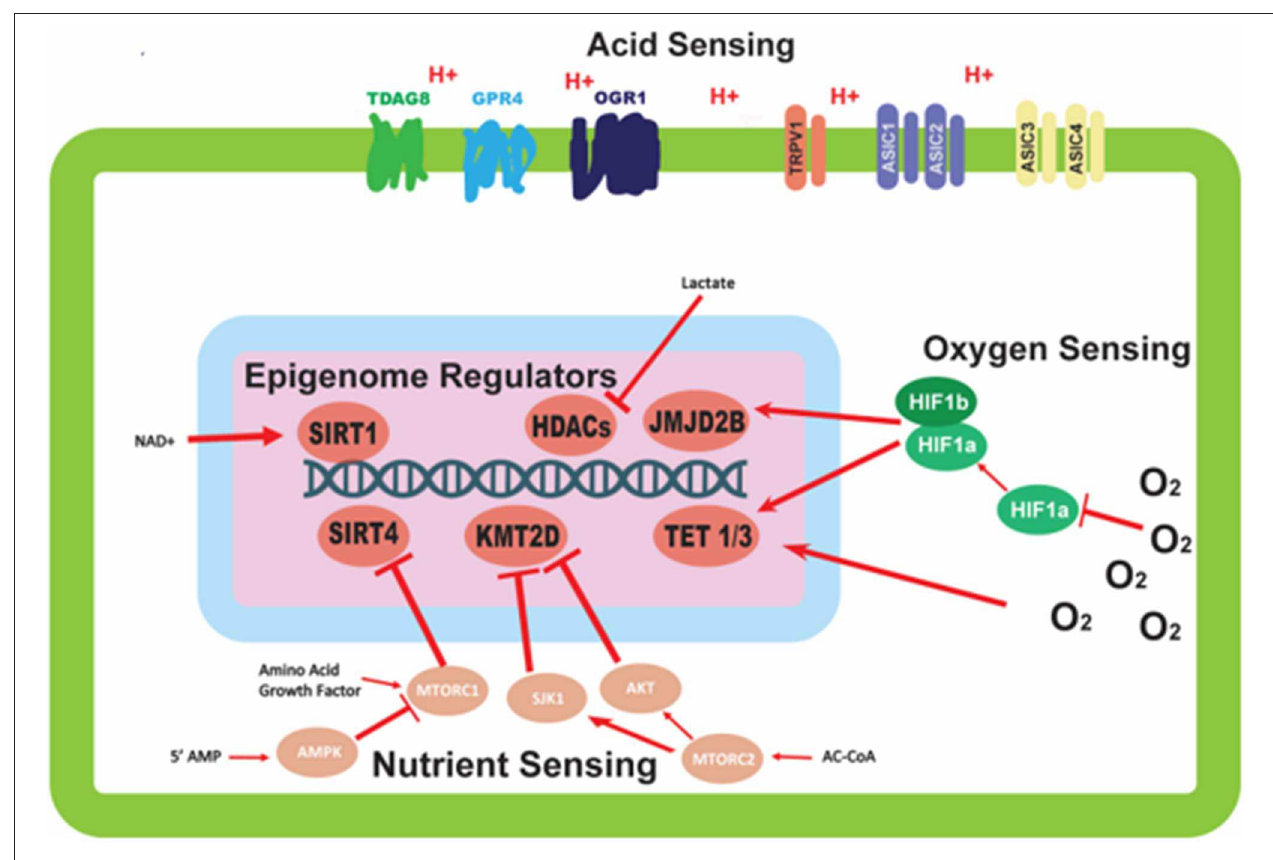
FIGURE 1 | Mechanisms of environmental sensing and their effects on epigenetic modifiers. This figure depicts the various avenues by which cells are able to detect perturbations in the environment, and the downstream effects of this sensing on epigenetic modifiers. Oxygen sensing mechanisms trigger dimerization of HIF-1 α and HIF-1 β proteins to affect epigenetic modifiers; oxygen also direct modulates activity of epigenetic modifiers. Nutrient sensing can initiate a signaling cascade, largely mediated by the mTORC complexes and AMPK protein, with the ability to alter the activity of epigenetic modifying proteins. Acid sensing proteins located on the outer membrane of the cell are able to sense the extracellular pH, but have no clear mechanism for altering the activity of epigenetic